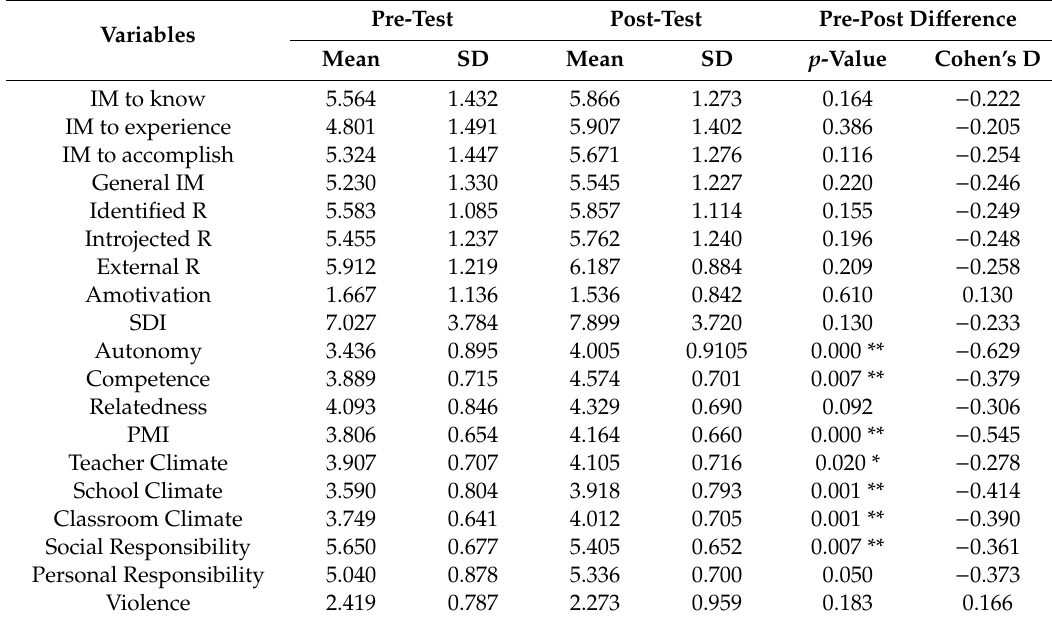
Table 2. Intervention